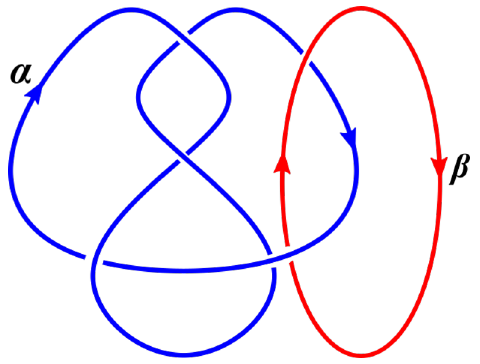
Figure 3. The two component link 4 1 # T 2 , 2 which is the connected sum of figure-eight knot and Hopf